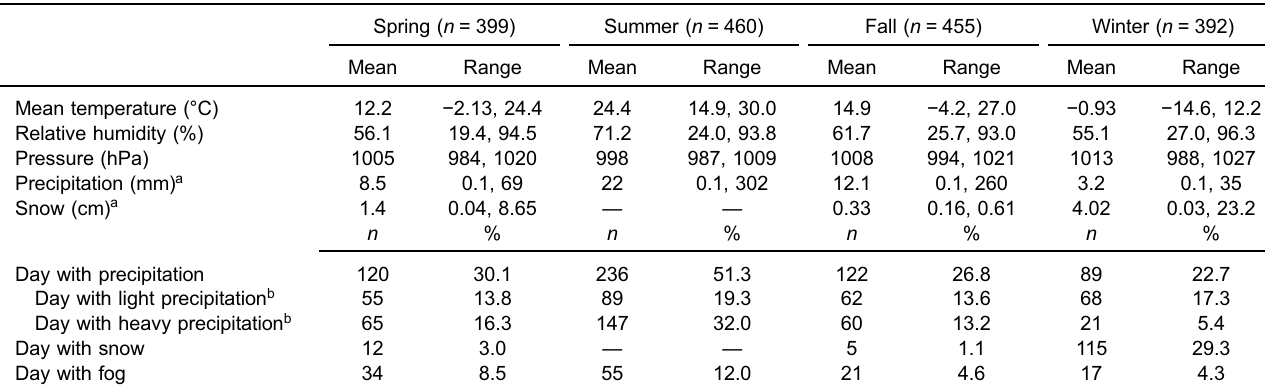
Table 1. Meteorological characteristics of Seoul from May 2007 to December 2011 Spring ( n =